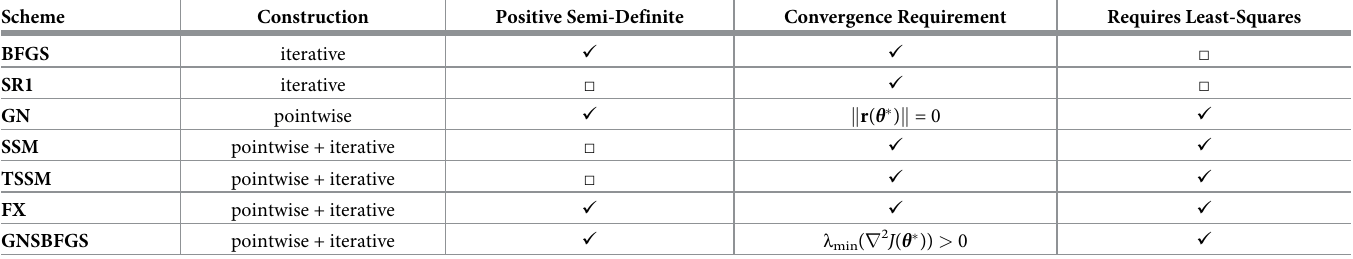
Table 2. Overview of properties of different Hessian approximation schemes. BFGS is the Broyden-Fletcher-Goldfarb-Shannon algorithm. SR1 is the Symmetric Rank- one update. GN is the Gauss-Newton approximation. SSM is the Structured Secant Method. TSSM is the Totally Structured Secant Method. FX is the hybrid method pro- posed by Fletcher and Xu [45]. GNSBFGS is the Gauss-Newton Structured BFGS method. The construction column indicates whether pointwise evaluation is possible or whether iterative construction is necessary. The positive semi-definite column indicates whether the approximation preserves positive semi-definiteness given a positive semi-definite